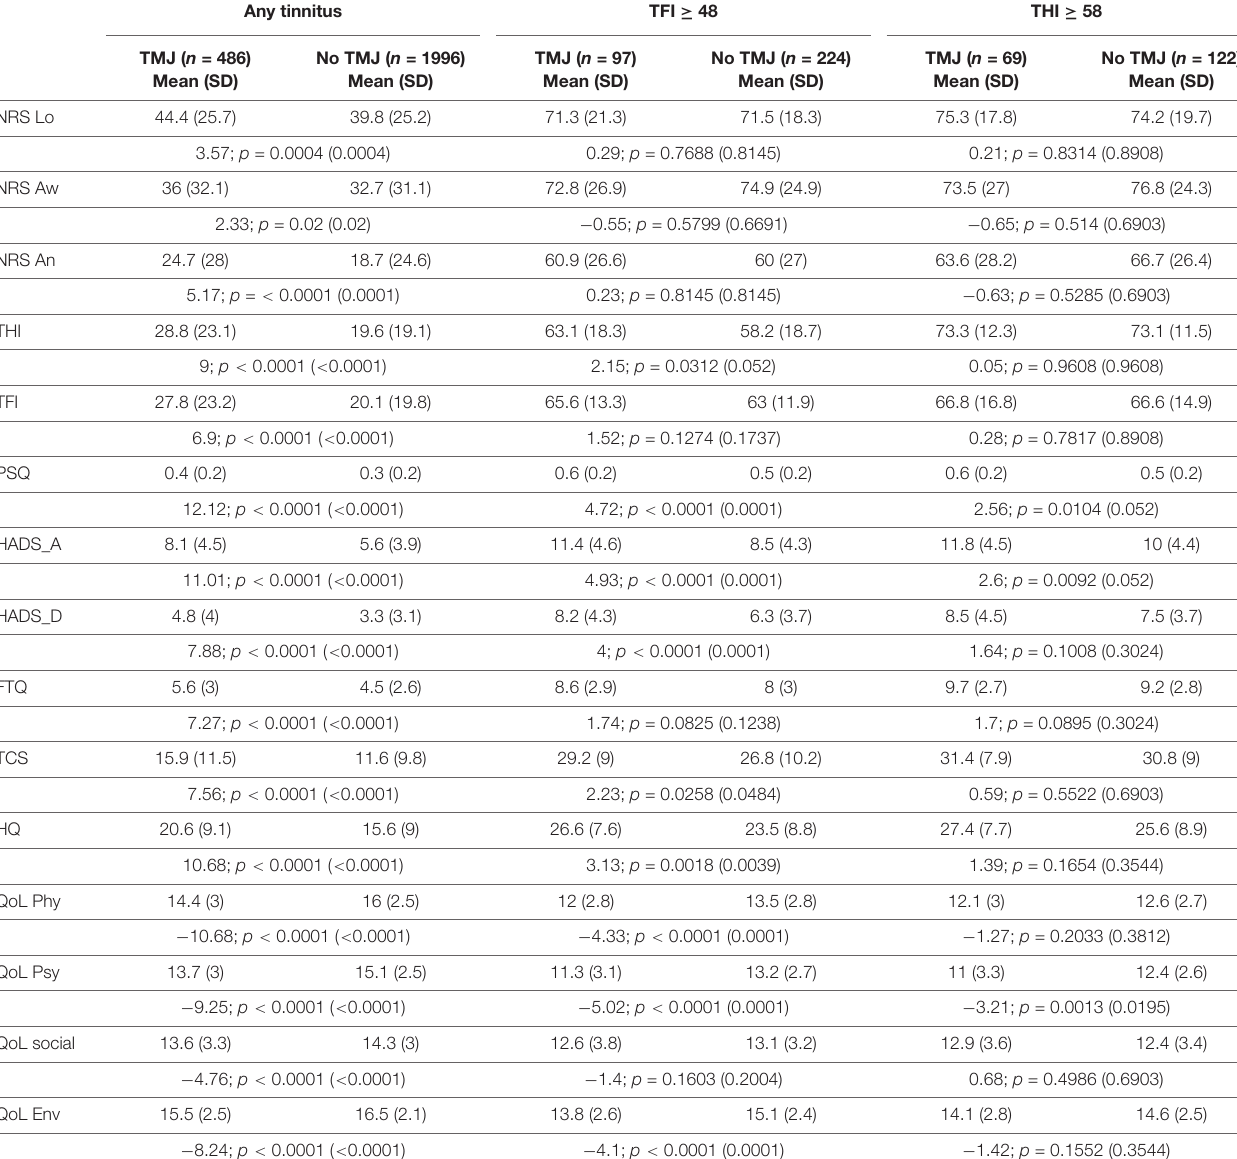
TABLE 2 | Questionnaire scores from subjects with tinnitus with or without TMJ complaints. Any